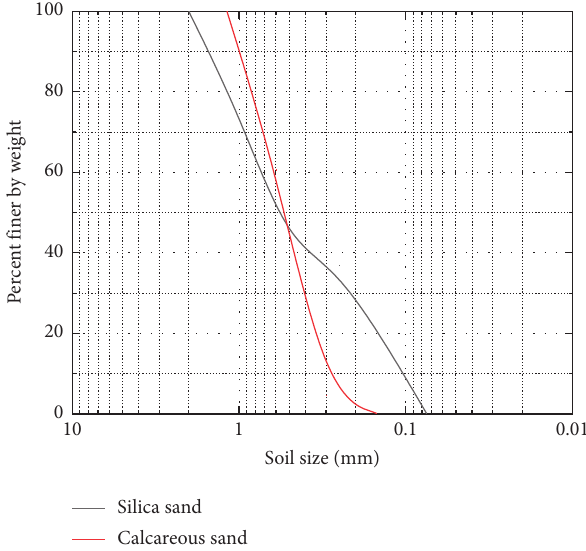
Figure 2: Grain size distributions of silica and calcareous